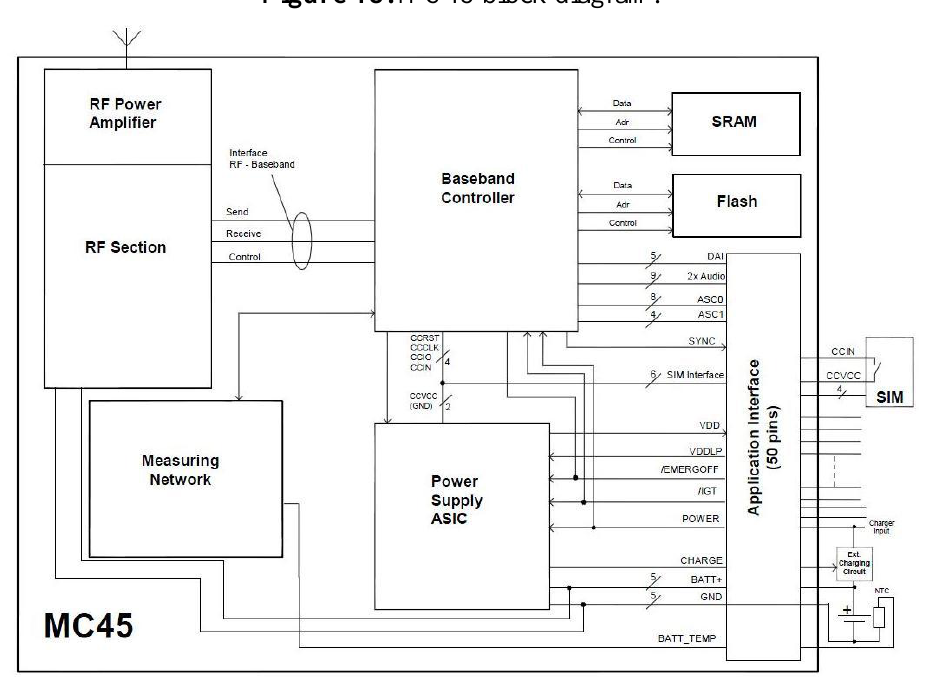
Figure 18. MC45 block diagram.